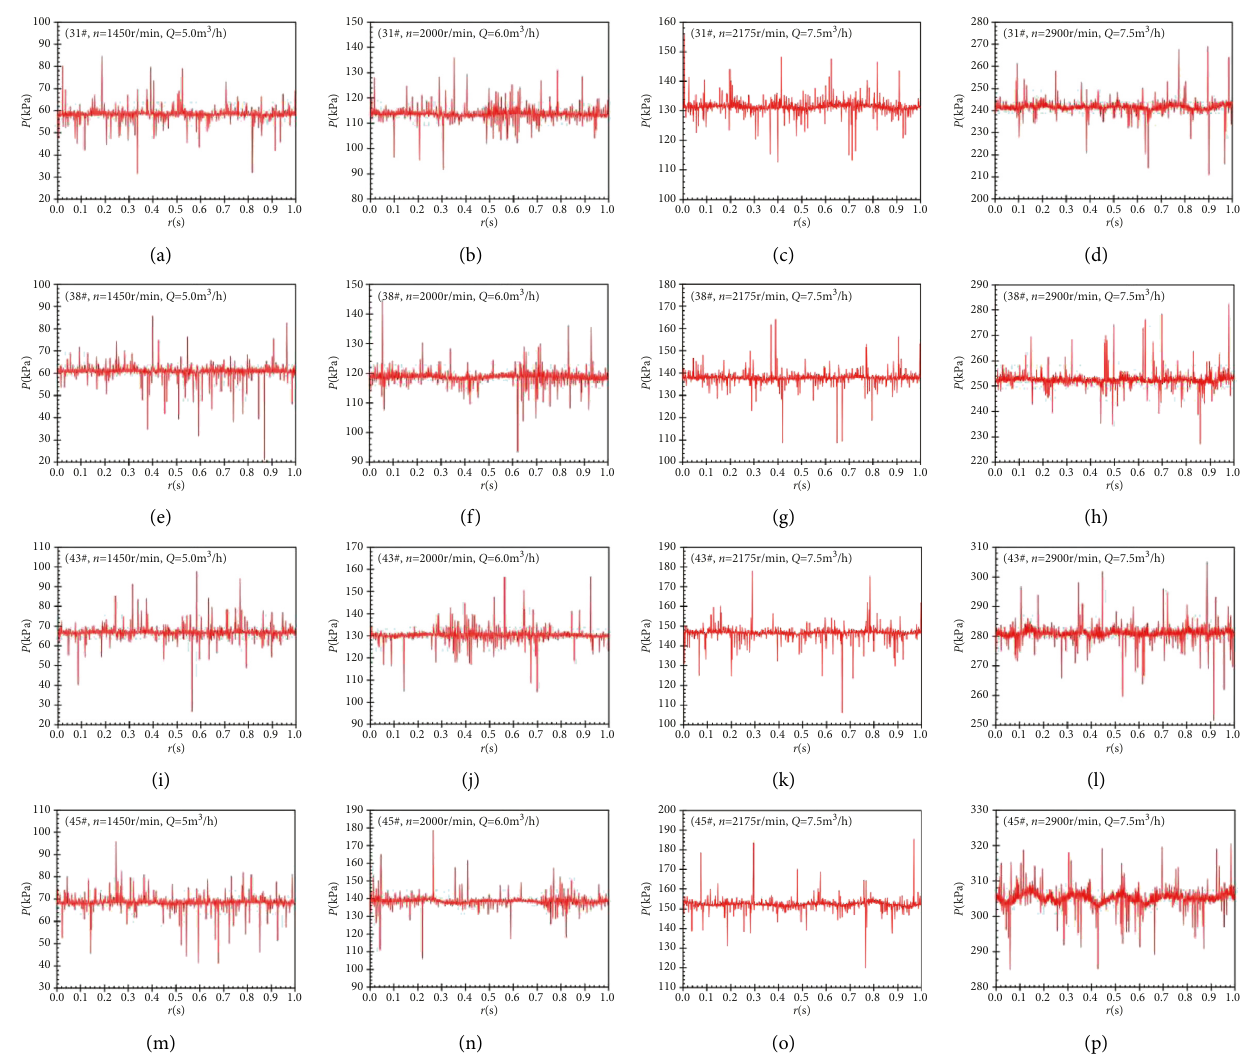
Figure 8: Variation characteristics of the instantaneous pressure on the middle section of the volute. Table 5: Pressure fluctuation amplitude on the middle section of volute casing. Rotational speed